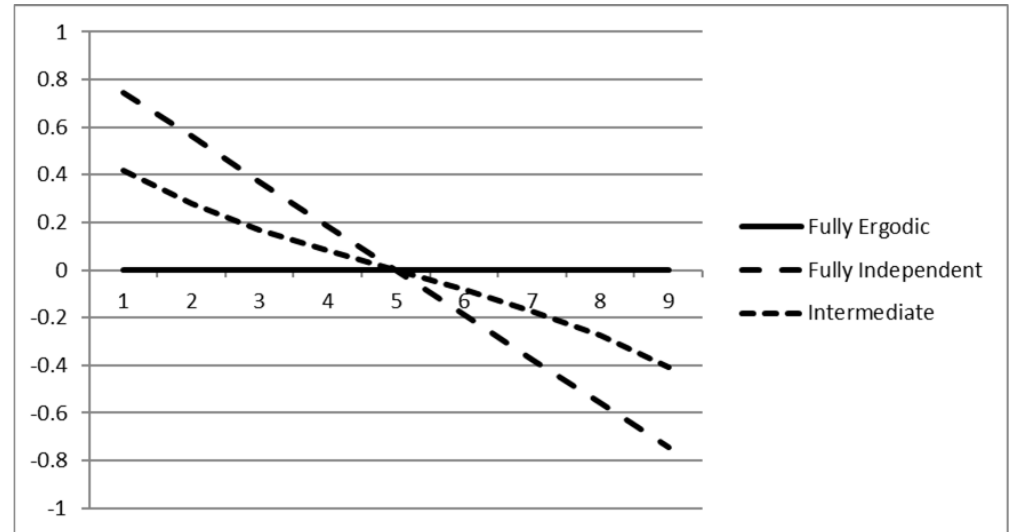
Figure 3. Scree plot for three situations of ergodicity: fully ergodic (independently sampled covariance matrices), fully non-ergodic (identical covariance matrices), and an intermediate case with a 50%